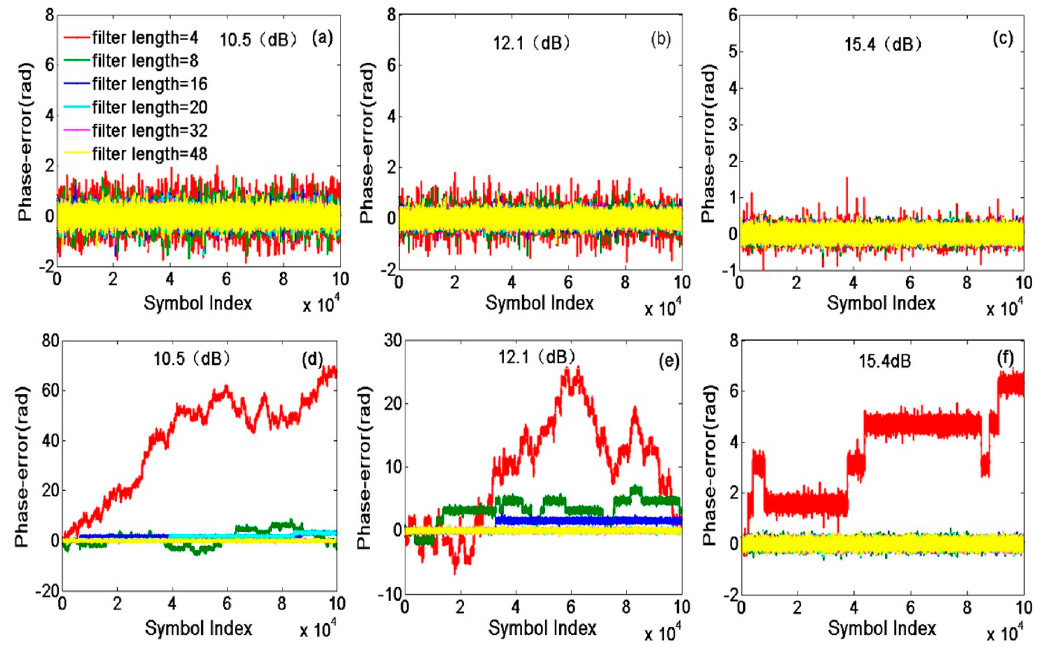
Figure 3. Phase errors for ( a – c ) the carrier phase estimation (CPE) scheme, ( e – f ) the CPE + pilot-aided-phase-unwrap (PAPU) scheme .